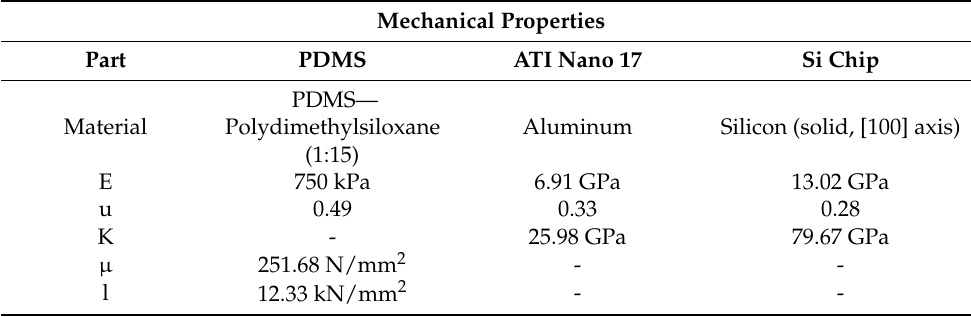
Table 1. Parameters used for each material in the mechanical